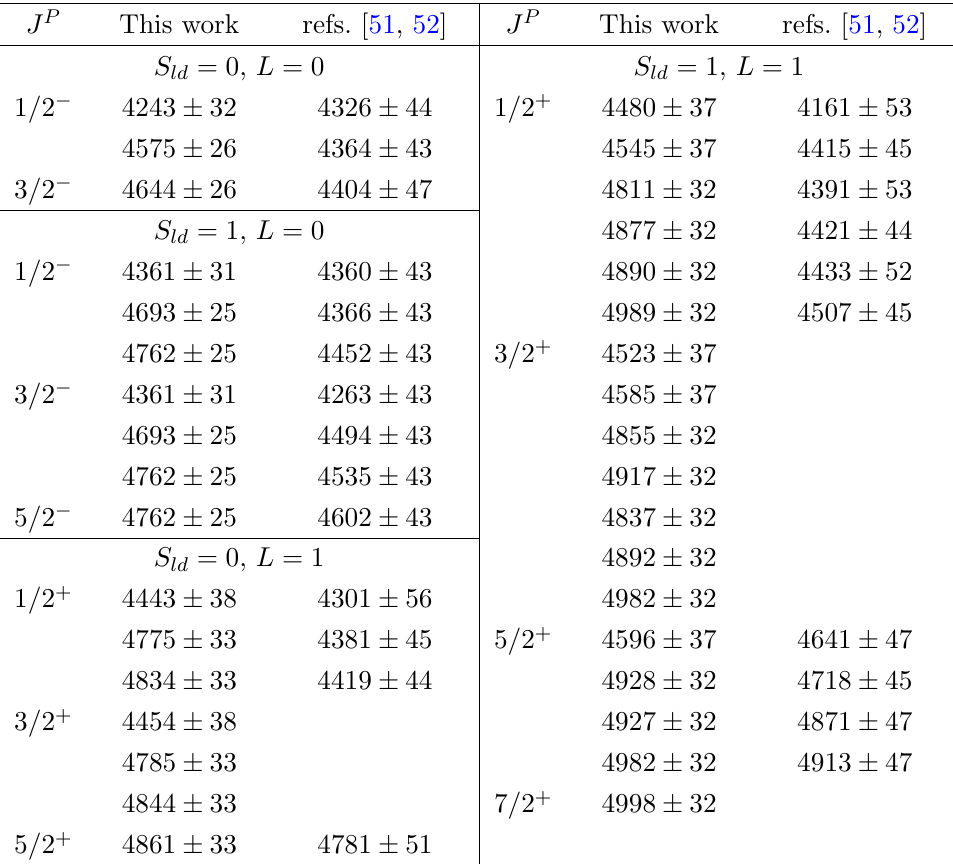
Table 12 . Masses of the hidden-charm doubly-strange pentaquarks (in MeV) with both the heavy and light strange diquarks, i.e. having the structure ((cid:22) c (cid:22)3 [ cs ] (cid:22)3 [ sq ] (cid:22)3 ), where q is u - or d -quark, and their comparison with the results presented in [51, 52]. For the P -wave pentaquarks, the values of the orbital, spin-orbit and tensor couplings are taken from table